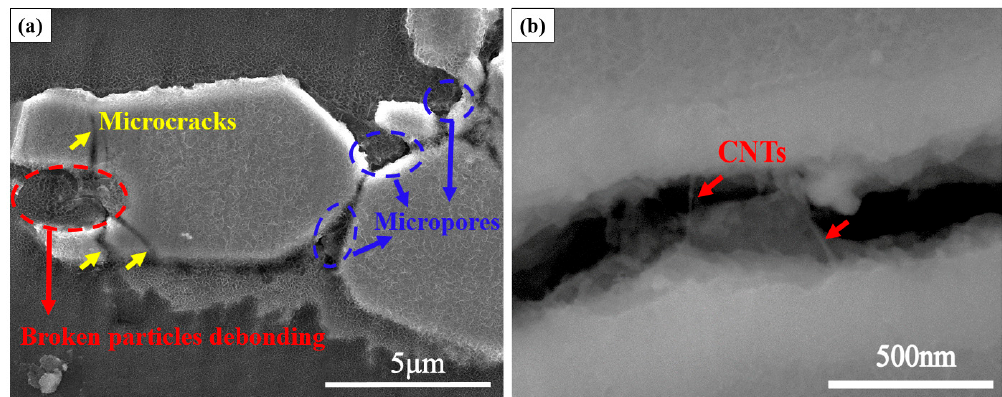
Figure 8. ( a ) High magnification image of broken Mn-rich phases; ( b ) CNTs in the microcrack.